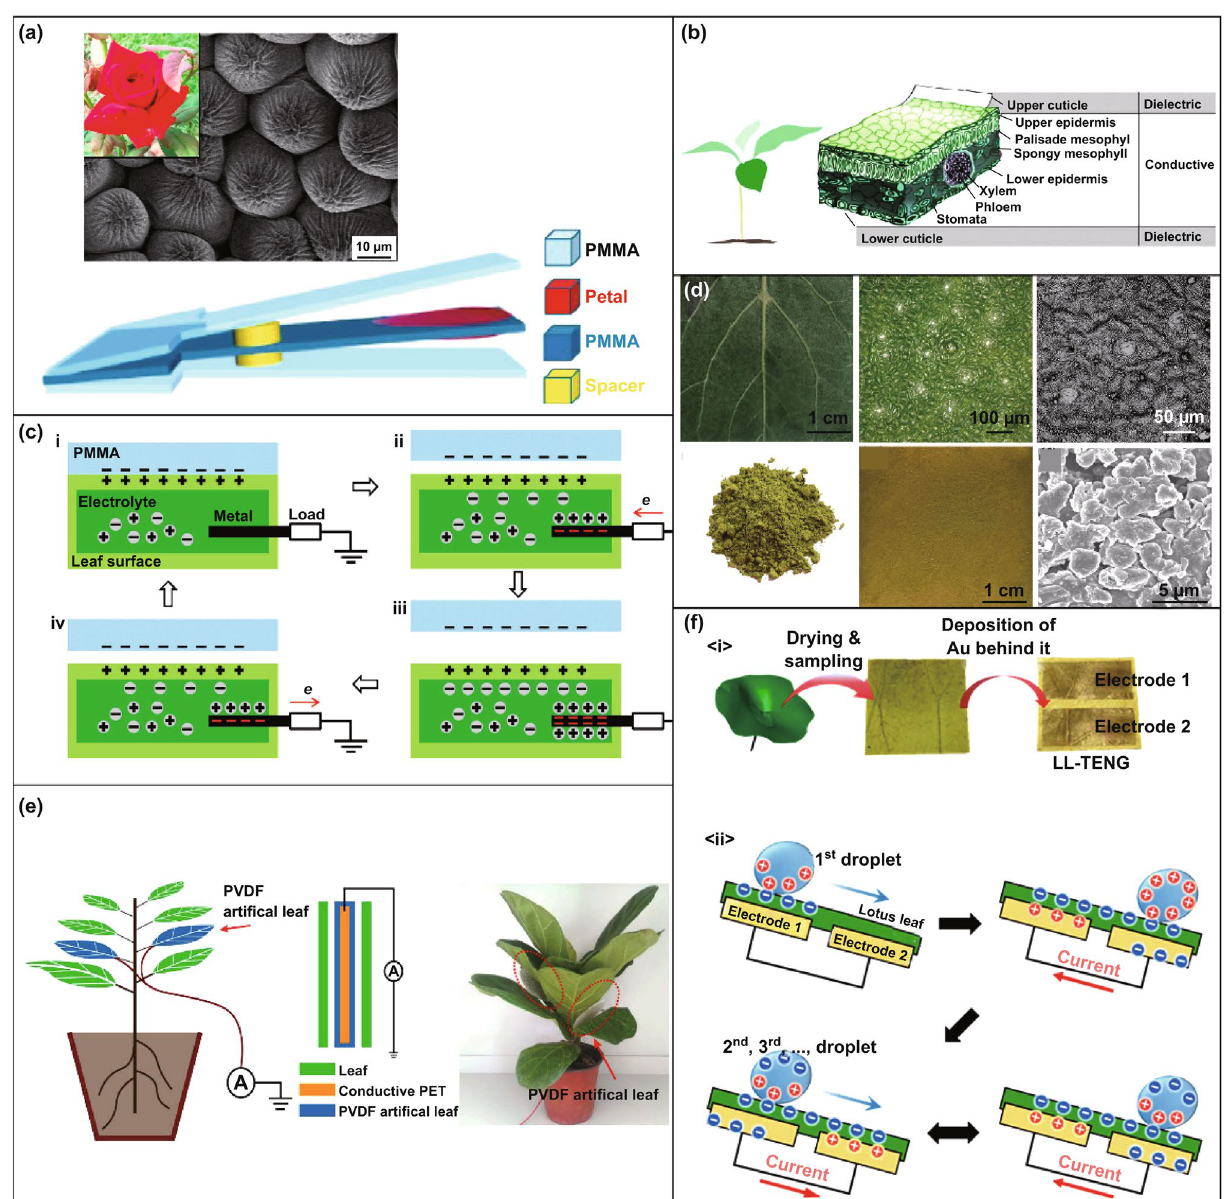
Fig. 2 The design of TENGs using plants: a surface of the petal rose and schematics of the contact‑separation mode TENG with petal. Reprinted with permission from Ref. [60]. Copyright (2018) Published by Elsevier Ltd. b Schematics of the rhododendron leaf as an electric bilayer structure. Reprinted with permission from Ref. [61]. Copyright (2018) Wiley‑VCH Verlag GmbH & Co. KGaA, Weinheim. c Schematic illustration of the working principles of leaf TENG in the single‑electrode mode. i) contact state, ii) separating state, iii) separated state, iv) approaching state. Reprinted with permission from Ref. [62]. Copyright (2018) Wiley‑VCH Verlag GmbH & Co. KGaA, Weinheim. d Structure of the fresh leaf and dry powder. e Schematics and proof of the concept of plant modification for designing TENGs. Reprinted with permission from Ref. [63]. Copyright (2018) Published by Elsevier Ltd; f Schematics of the water–solid contact. Reprinted with permission from Ref. [64]. Copyright (2017) Published by Elsevier